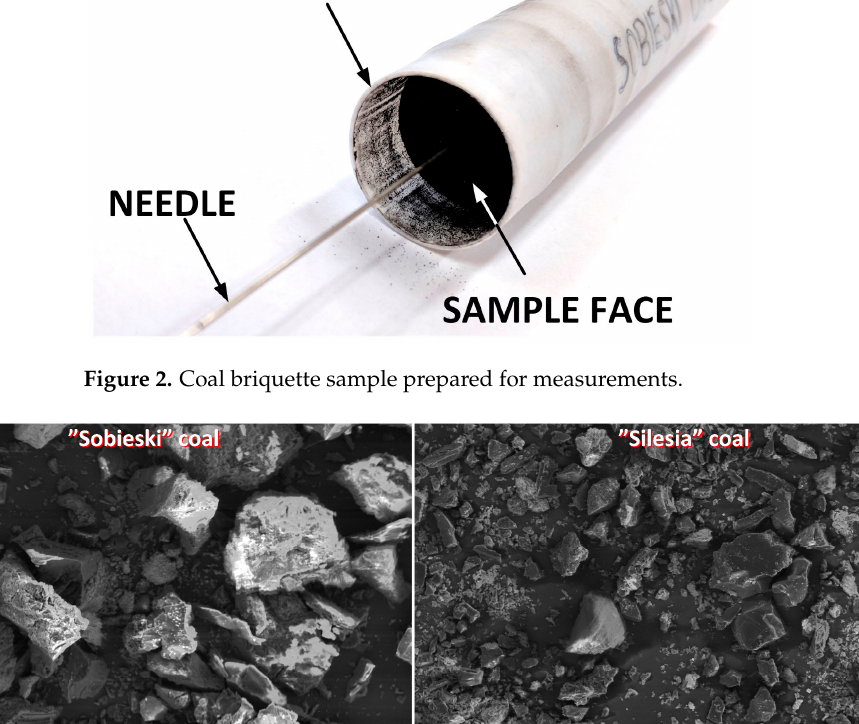
Figure 2. Coal briquette sample prepared for measurements.